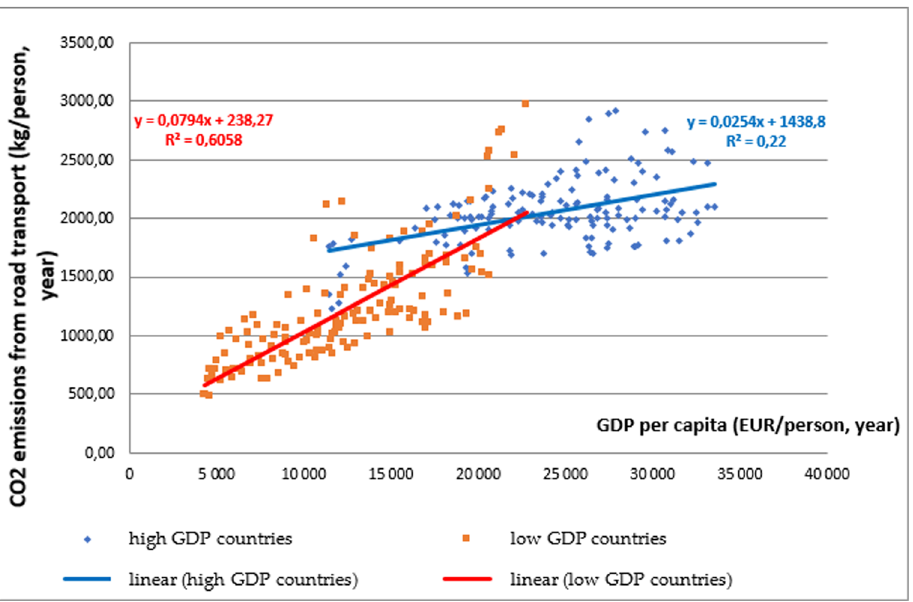
Figure 5: Dependence of CO 2 emissions on GDP – approximation of linear functions, data source: http://epp.eurostat.ec.europa.eu/portal/ page/portal/eurostat/home/; United Nation Framework Convention on Climate Change ( UNFCCC ) , own